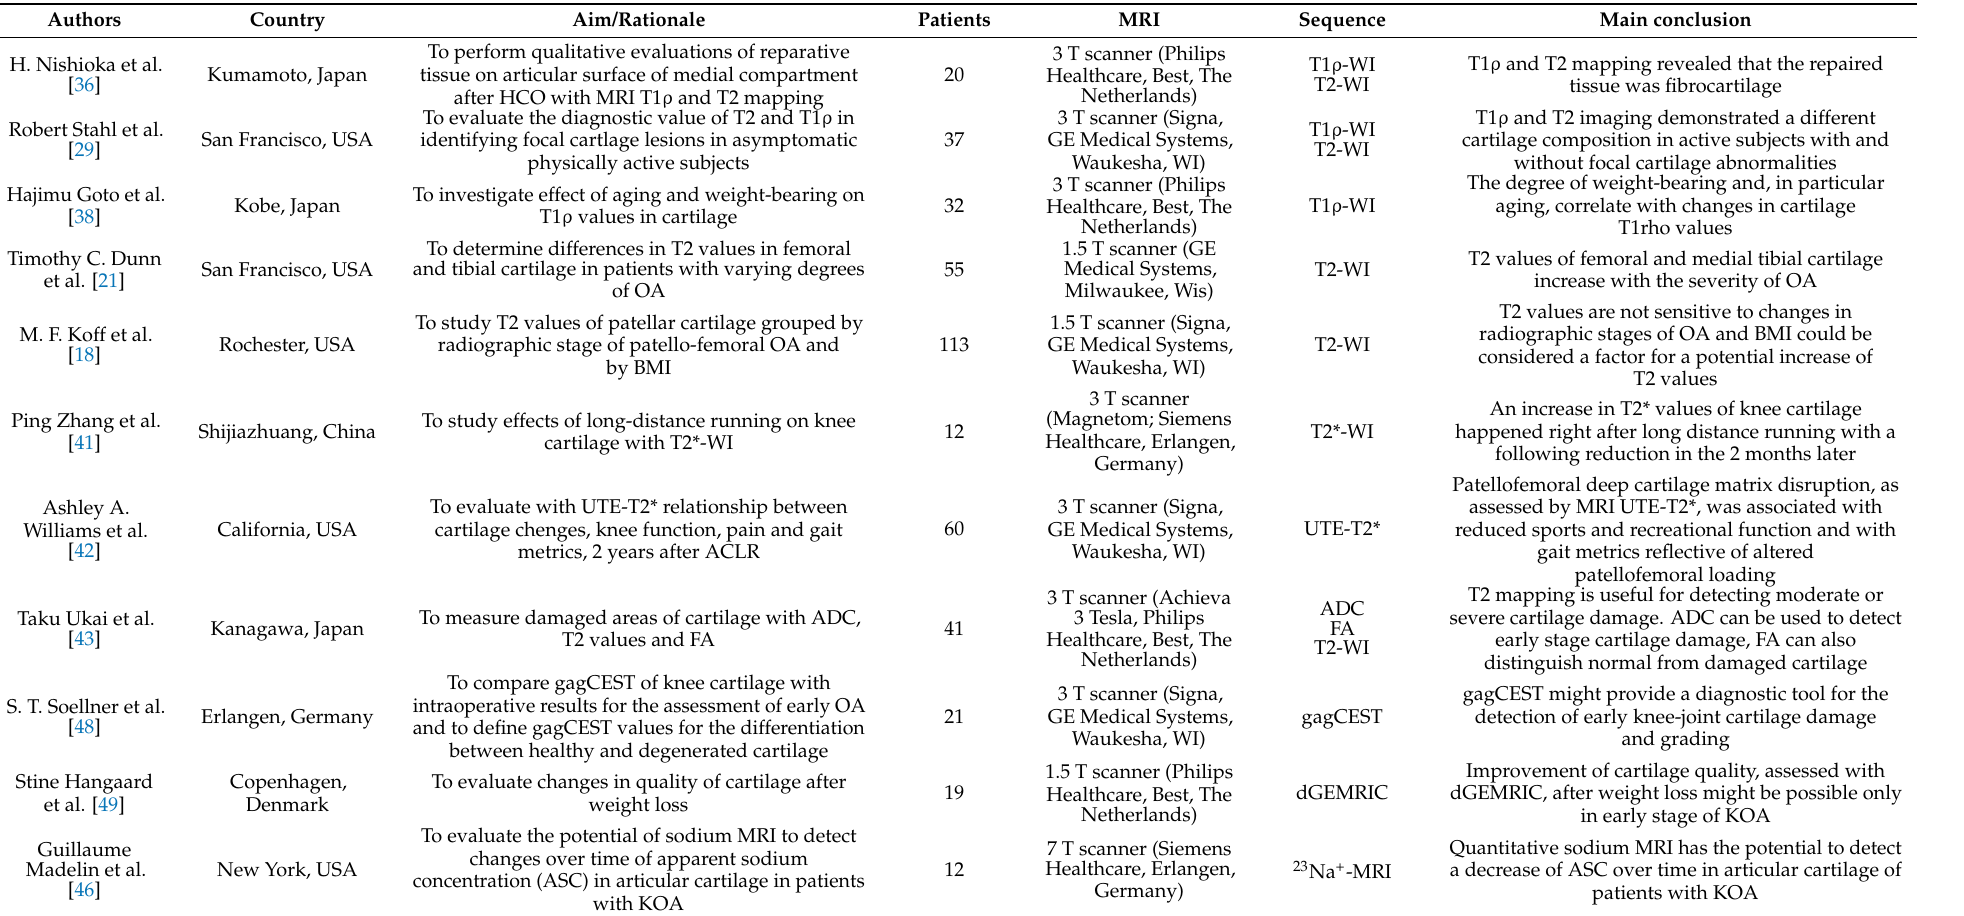
Table 2. Main characteristics of representative studies investigating novel MRI techniques for knee